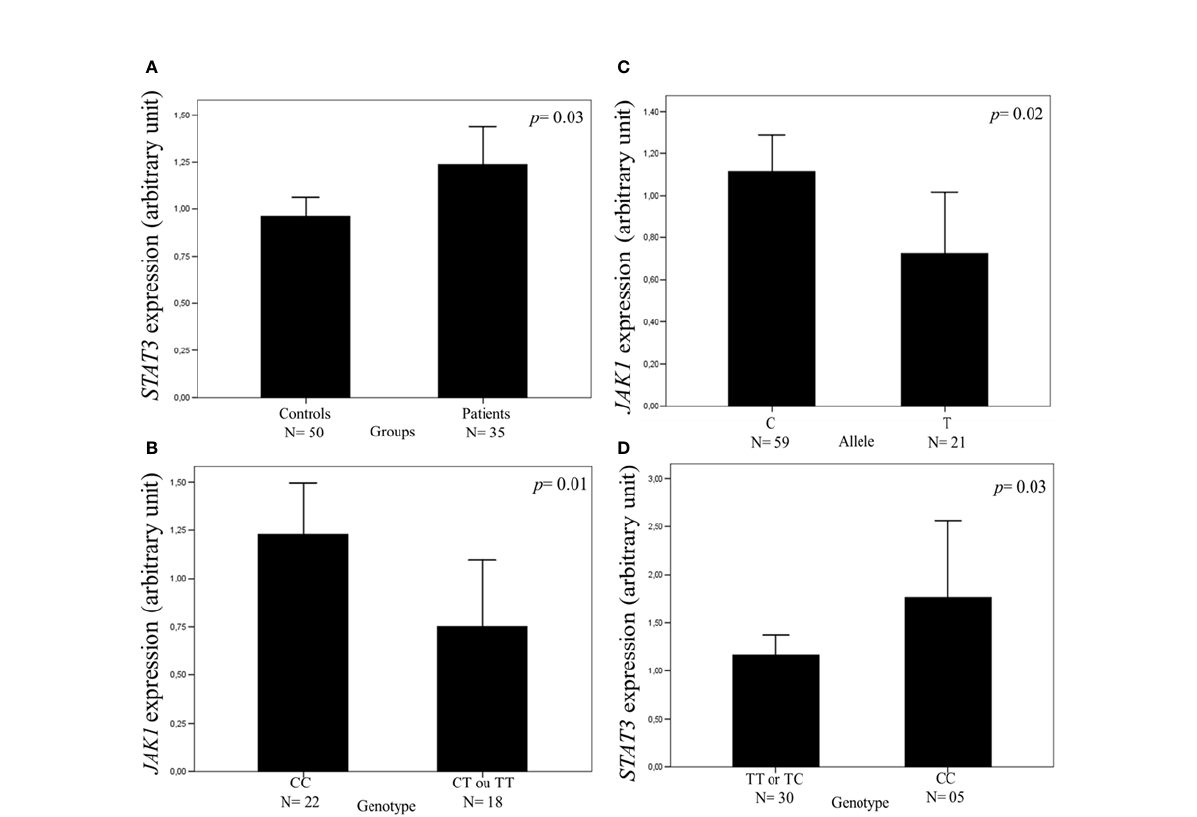
FIGURE 1 Expression of the JAK1 and STAT3 genes in the leukocytes of peripheral blood samples measured by real-time polymerase chain reaction. The relative expression level was normalized by b -actin reference gene with the 2 -DDCt cycle threshold method. The values of 15% of the samples were repeated in separate experiments with 100% agreement, and the results are expressed in arbitrary units (AUs). The results are shown as means between groups. For the statistical tests, values with p < 0.05 were considered signi fi cant. The STAT3 expression was higher in patients with cutaneous melanoma (CM) than in controls (1.23 vs. 0.96 AU) (A) . The JAK1 expression was higher in CM patients with CC genotype (B) and with allele C (C) than in those with CT or TT genotype and allele T of JAK1 c.991-27C>T, the single-nucleotide variant (SNV) (1.22 vs. 0.75 and 1.11 vs. 0.75 AU, respectively). The STAT3 expression was higher in CM patients with CC genotype than in those with TT or TC genotype of c.*1671T>C SNV (1.76 vs. 1.16 AU) (D)